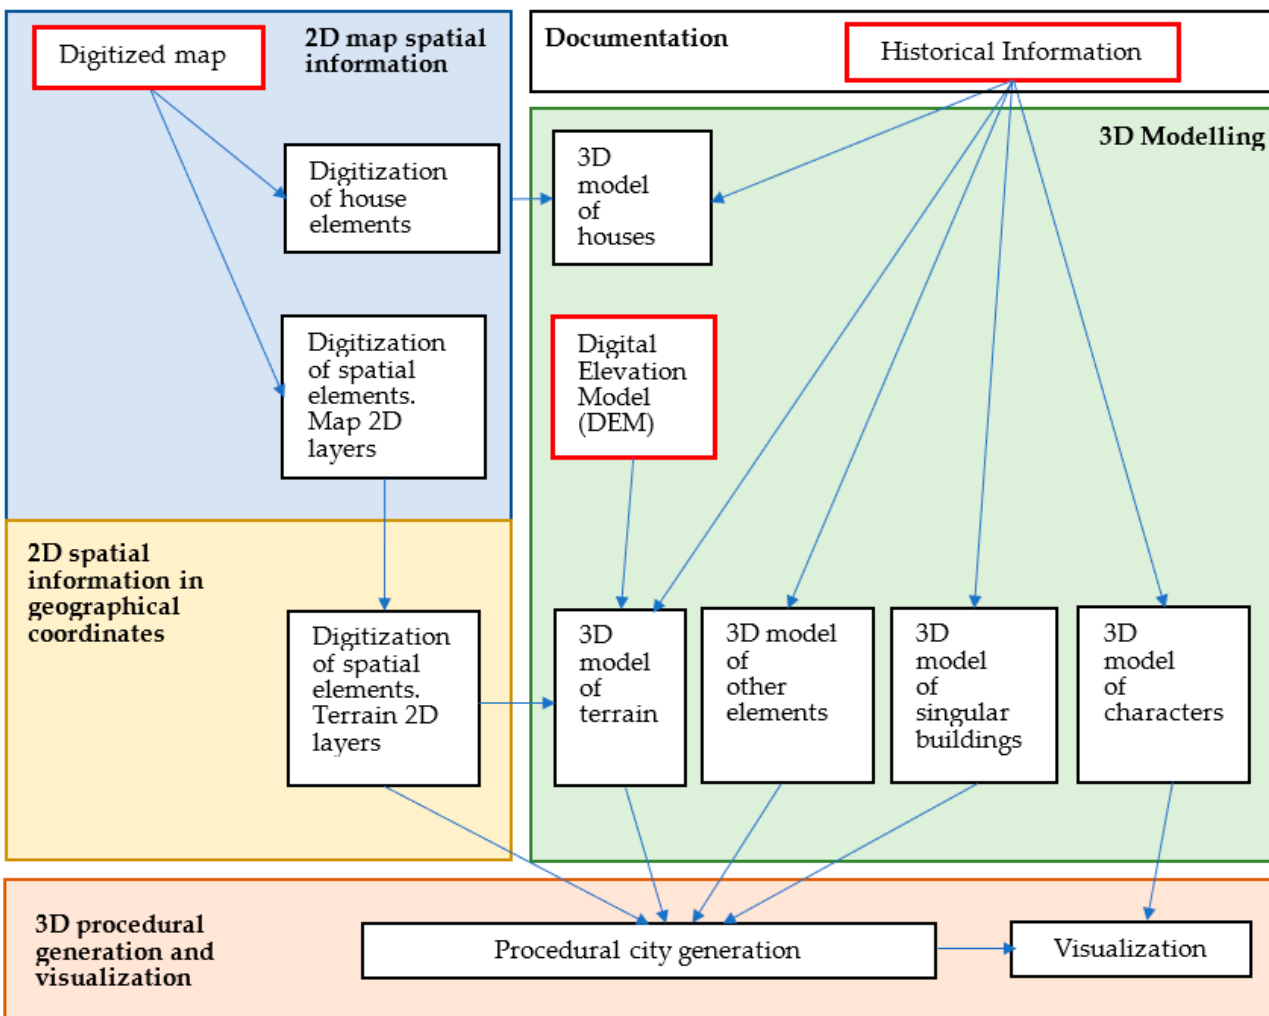
Figure 1. Workflow of the 3D reconstruction process.